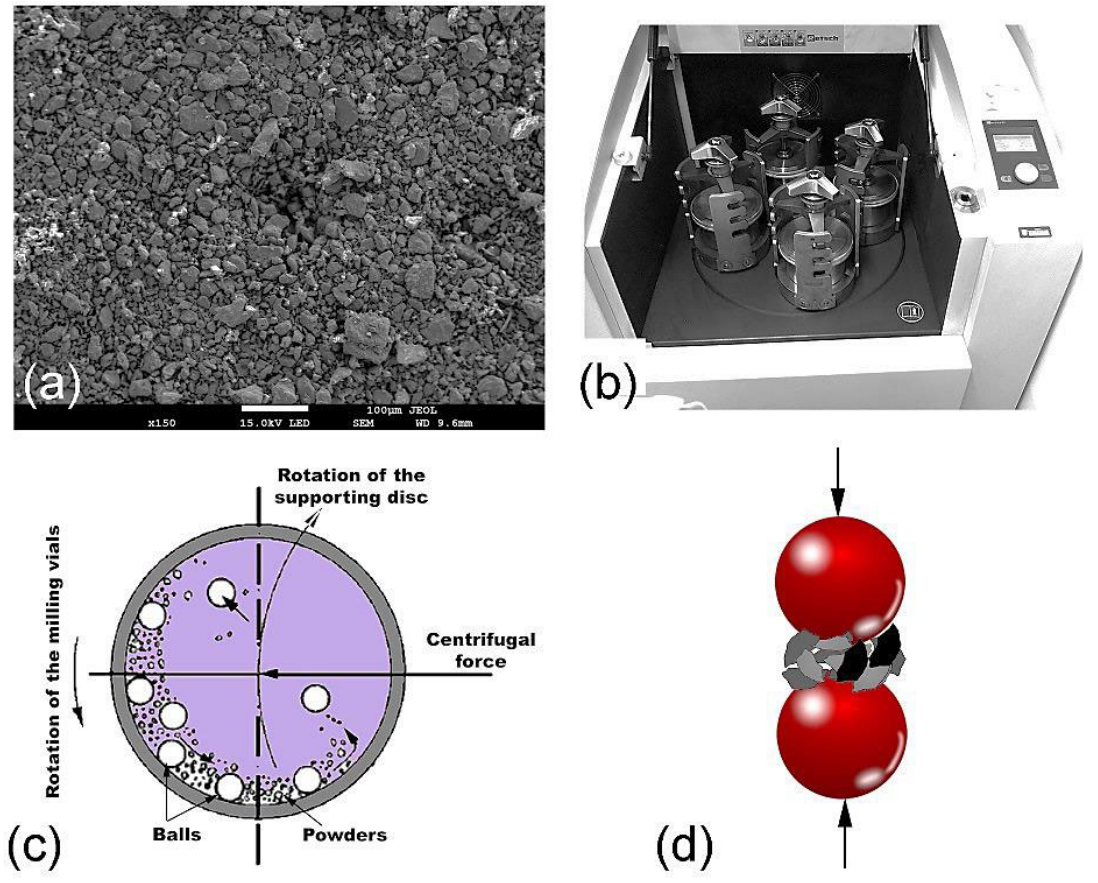
Figure 2. ( a ) SEM micrograph of Cu 50 Zr 40 Ni 10 powder particles obtained upon the disintegration of the master alloy using disc mill facility, ( b ) planetary-type high-energy ball mill, ( c ) schematic drawing of a high-energy planetary ball mill, ( d ) schematic illustration of ball-powder-ball colli-